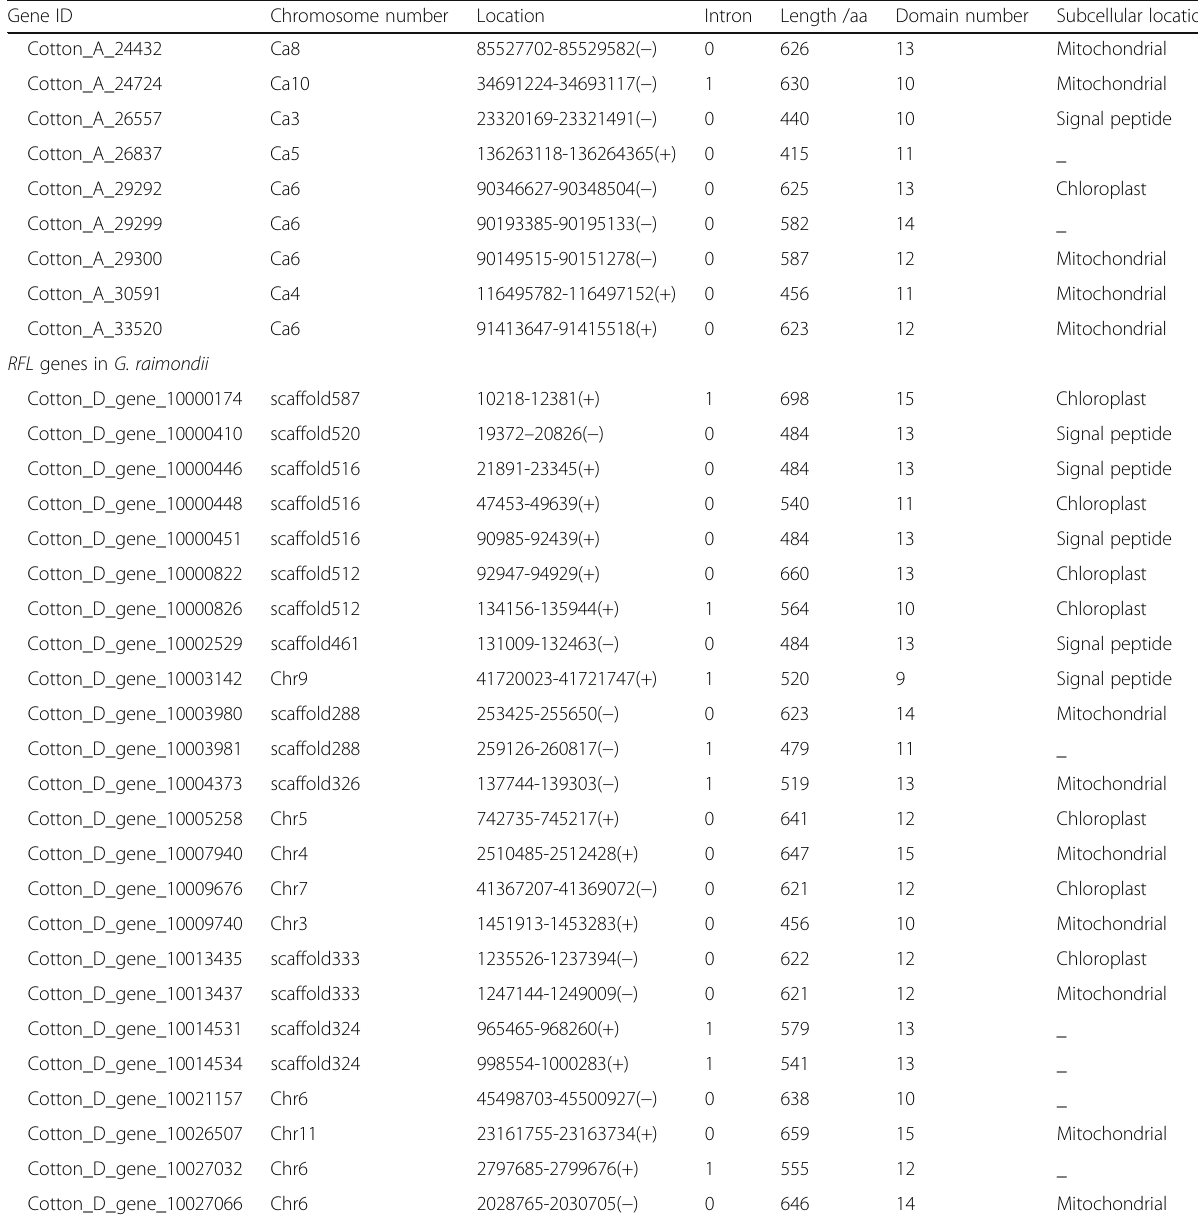
Table 1 Characteristics of RFL genes and predicted properties of RFL proteins in three Gossypium species